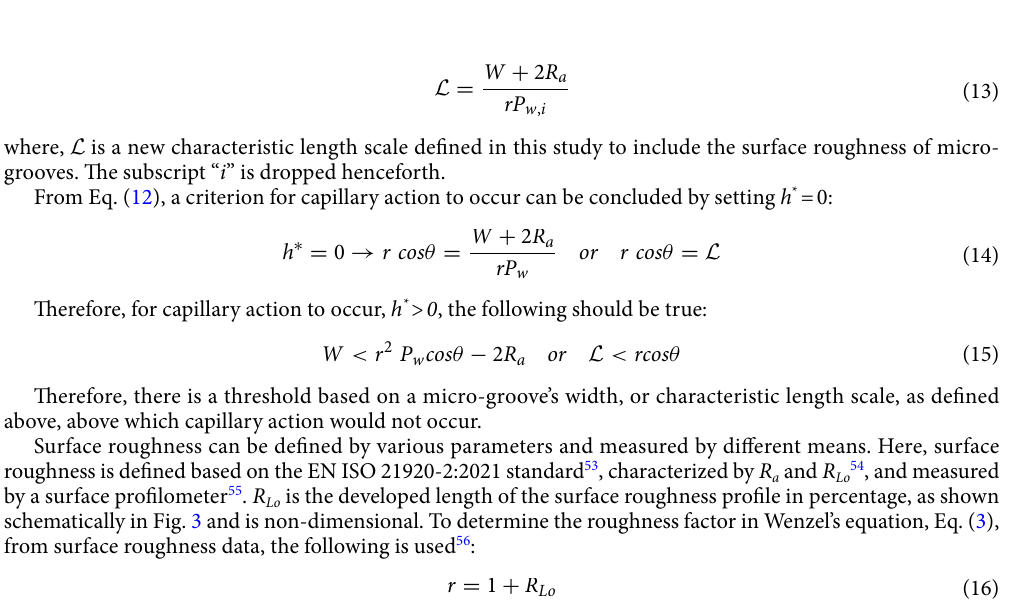
Figure 3. The actual surface roughness profile length vs. the ideal smooth surface length. R Lo is the percentage increase in the profile